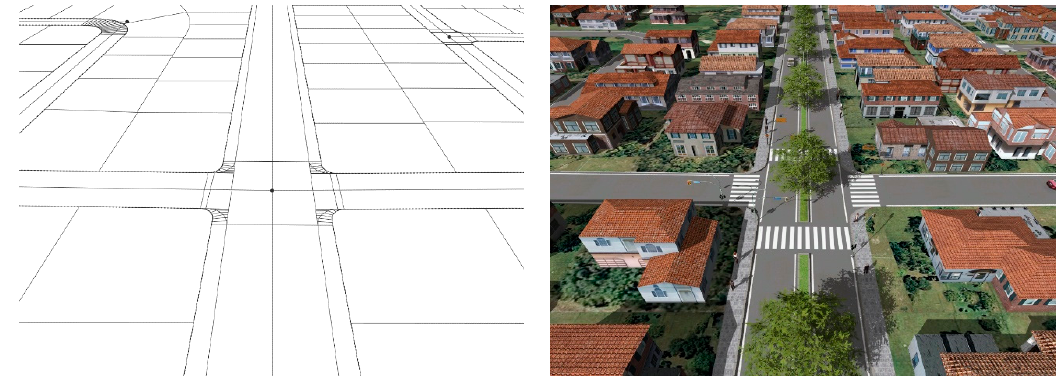
Figure 9. An example of the automated installation of roads using a rule file in procedural modeling.